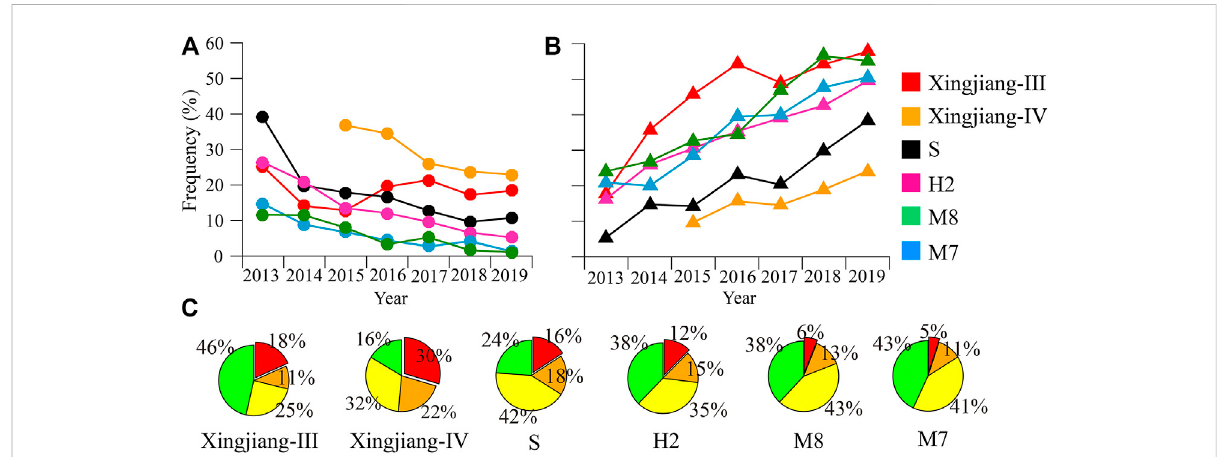
FIGURE 3 Occurrence frequencies of air quality (A) above the moderately polluted level and (B) the excellent rates in the Urumqi-Changji-Shihezi region (Xingjiang- Ⅲ , red), southern Xingjiang (Xinjiang- Ⅳ , orange), the south of North China to the west of Huang-Huai Region (S, black), the Fenhe and Weihe Plain (H2, pink), the north of North China (M8, green) and the Yangtze River Delta (M7, blue) from 2013 to 2019. (C) Average occurrence frequencies of the air quality at the good level (green, daily PM 2.5 concentration between 0 and 35 μ g · m − 3 ), moderate level (yellow,